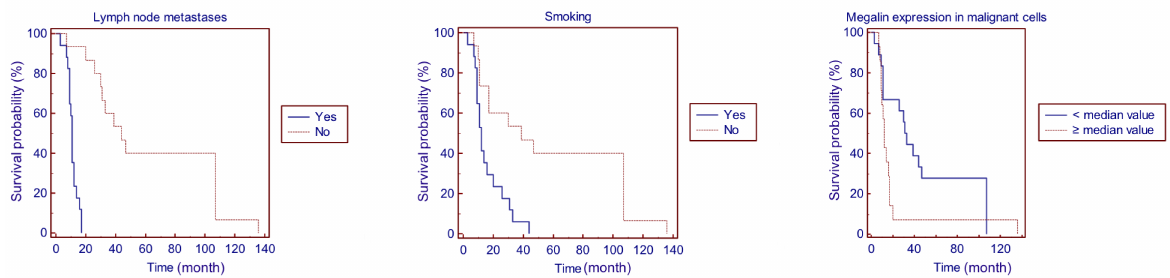
Figure 3. Kaplan–Meier survival curves regarding lymph node metastases, smoking history and megalin expression (<median value/ ≥ median